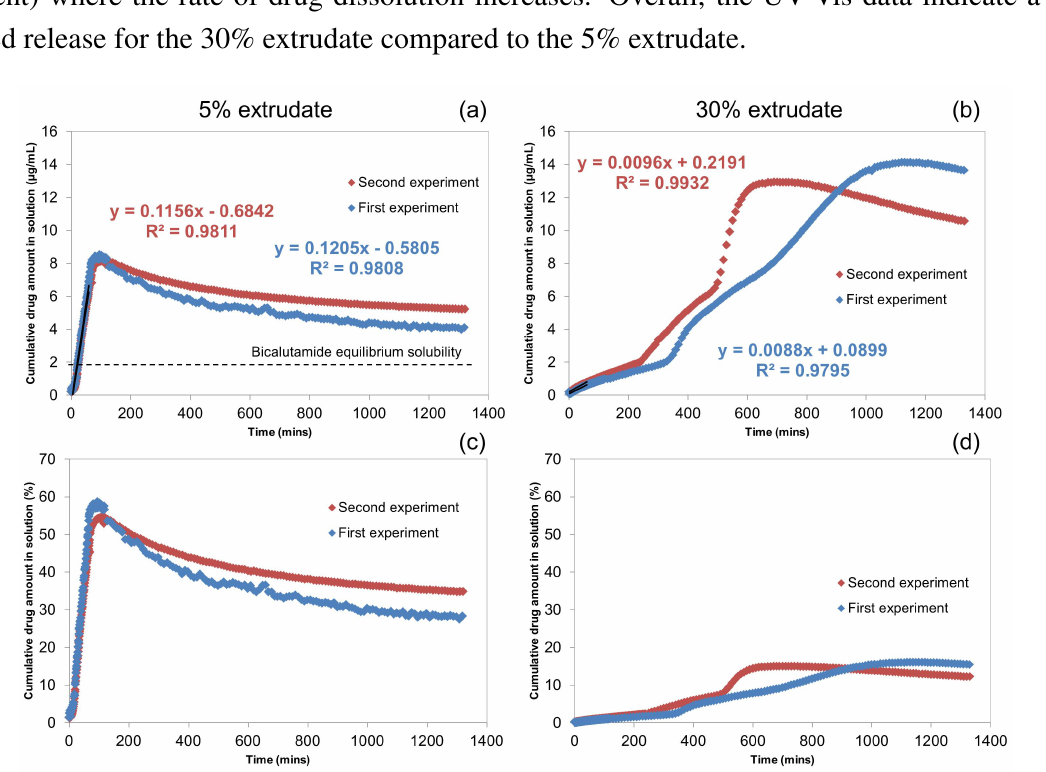
Figure 2. UV-Vis dissolution profiles of bicalutamide released from the 5% and 30% extrudates. ( a , c ) Drug release for the 5% extrudate expressed in Cumulative drug amount in solution (µg · mL − 1 ) and Cumulative drug amount in solution (%) respectively; ( b , d ) Drug release for the 30% extrudate expressed in Cumulative drug amount in solution (µg · mL − 1 ) and Cumulative drug amount in solution (%) respectively. The dissolution rates of the initial time-points were calculated using linear regression analysis. Linear best fits for the 5% and 30% dissolution experiments are